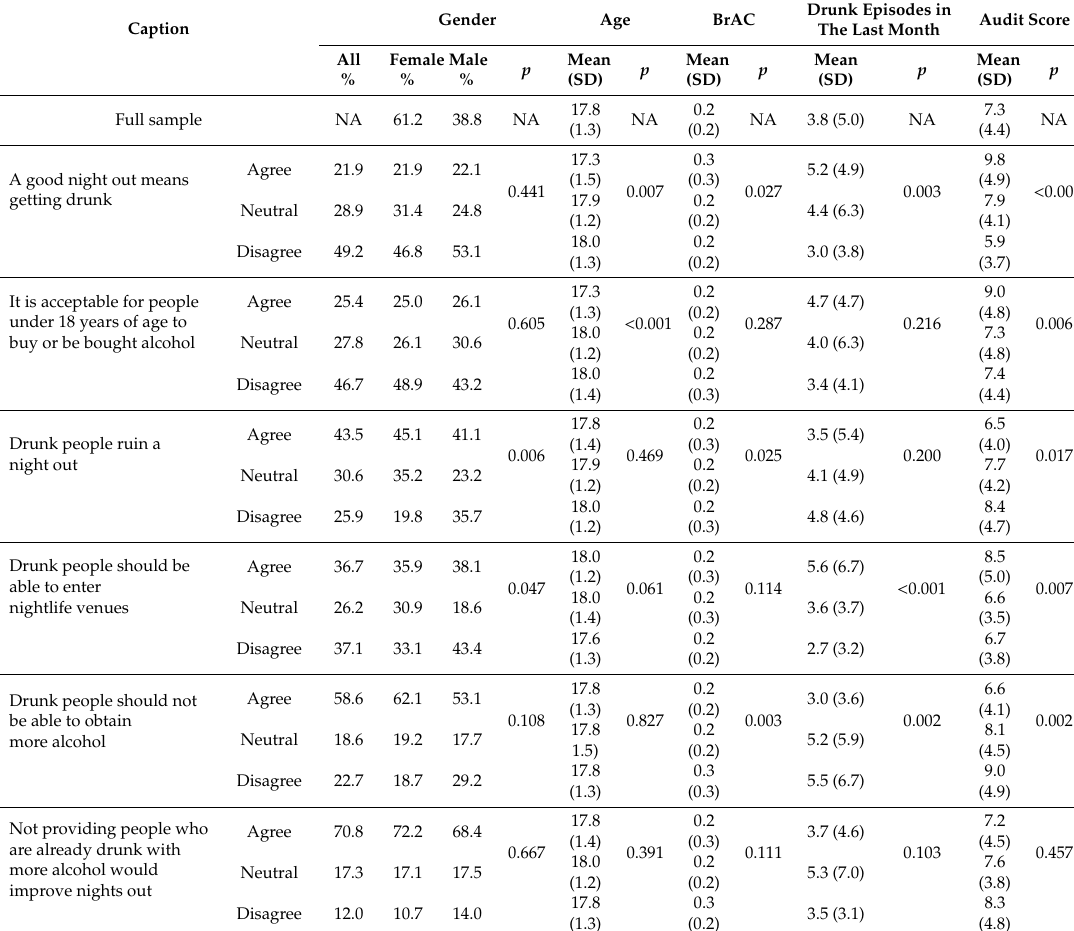
Table 2. Bivariate analysis to compare attitudes by demographics and personal alcohol